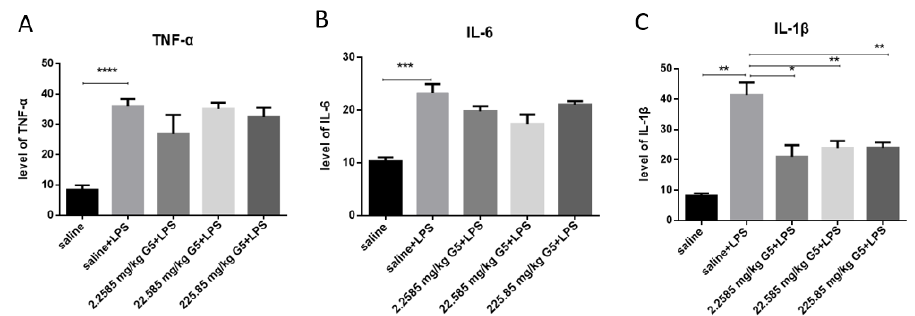
Figure 4. Effect of G5 on Inflammatory factors (TNF- α , IL-6, IL-1 β ). Mice serum were collected 48 h post-LPS challenge and subjected to RIA kit. The concentrations of ( A ) TNF- α , ( B ) IL-6, and ( C ) IL-1 β in serum are presented. For statistical significance, * p < 0.05, ** p < 0.01, *** p < 0.005, **** p < 0.001 for one-way ANOVA followed by Fisher’s least significant difference test; n = 7, all data are presented as mean ±